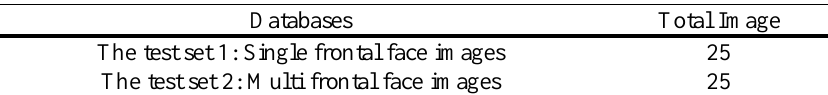
Table 4. Algorithm for the proposed method (see Figure